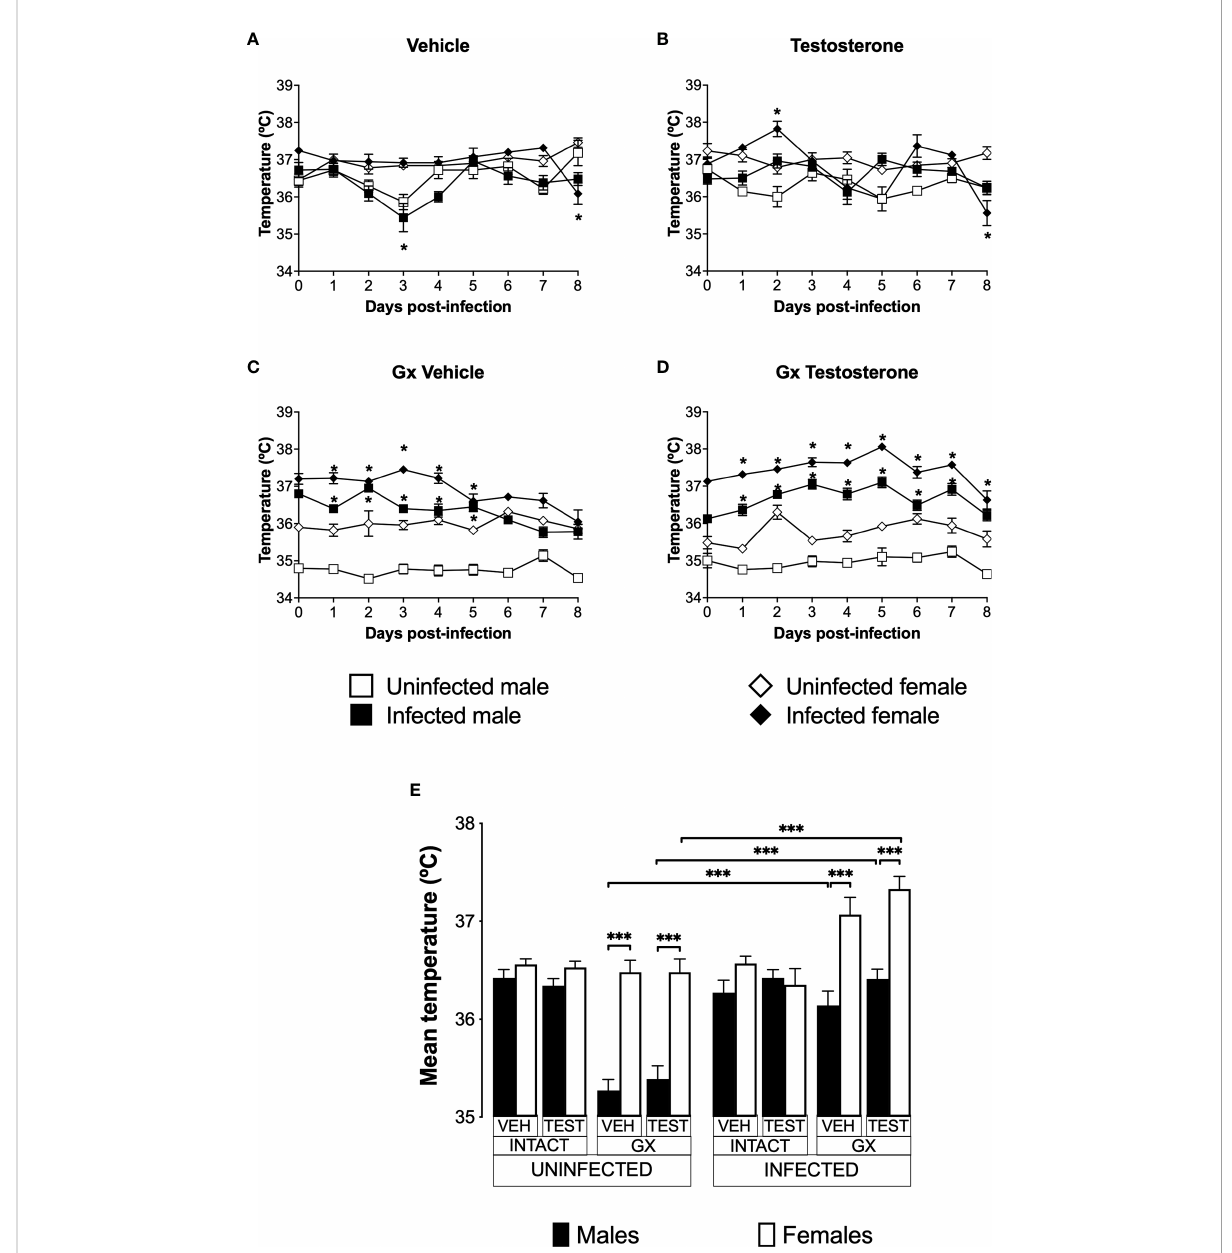
FIGURE 5 Gonadectomy generated a dimorphic pattern in the temperature of mice infected with P. berghei ANKA. We analysed 8 groups of males and 8 groups of females, 4 groups of each sex were gonadectomised (GX), and the other 4 groups were left intact; four weeks after surgery, two groups of intact and two GX mice of each sex were administered testosterone for 3 weeks, the other two received vehicle for the same time. Finally, one intact and one GX group treated with testosterone of each sex were infected with P. berghei ANKA. The remaining groups were injected with PBS as infection controls. Temperature was measured in all groups from the day cero to day eight post-infection. (A) shows the temperature in intact male and female mice treated with vehicle that were infected or uninfected with the parasite; (B) displays the temperature in groups of male and female intact mice treated with testosterone infected or no with P. berghei ANKA; (C) shows the temperature in GX mice treated with vehicle infected or uninfected of both sexes; (D) indicates the temperature in the GX mice treated with testosterone infected or not with the parasite. Each point on the graphs represents the average ± SEM in each group. Asterisks (*) represent statistically signi fi cant differences between uninfected and infected groups, obtained by repeated measures ANOVA with a Bonferroni post-hoc test p ≤ 0.05. Finally, (E) shows the area under the curve analysis (AUC) of the vehicle-treated (VEH), testosterone-treated (TEST), intact (INTACT), or gonadectomised (GX) groups. Mice infected with P. berghei ANKA (INFECTED) or uninfected (UNINFECTED). Each bar represents the mean ± SEM. Asterisks denote statistical signi fi cance between 2 groups (*) p < 0.05; (***) p < 0.001; calculated by Kruskal-Wallis analysis with Dunn ’ s post-hoc test. The whole experiment was conducted in duplicate (n =